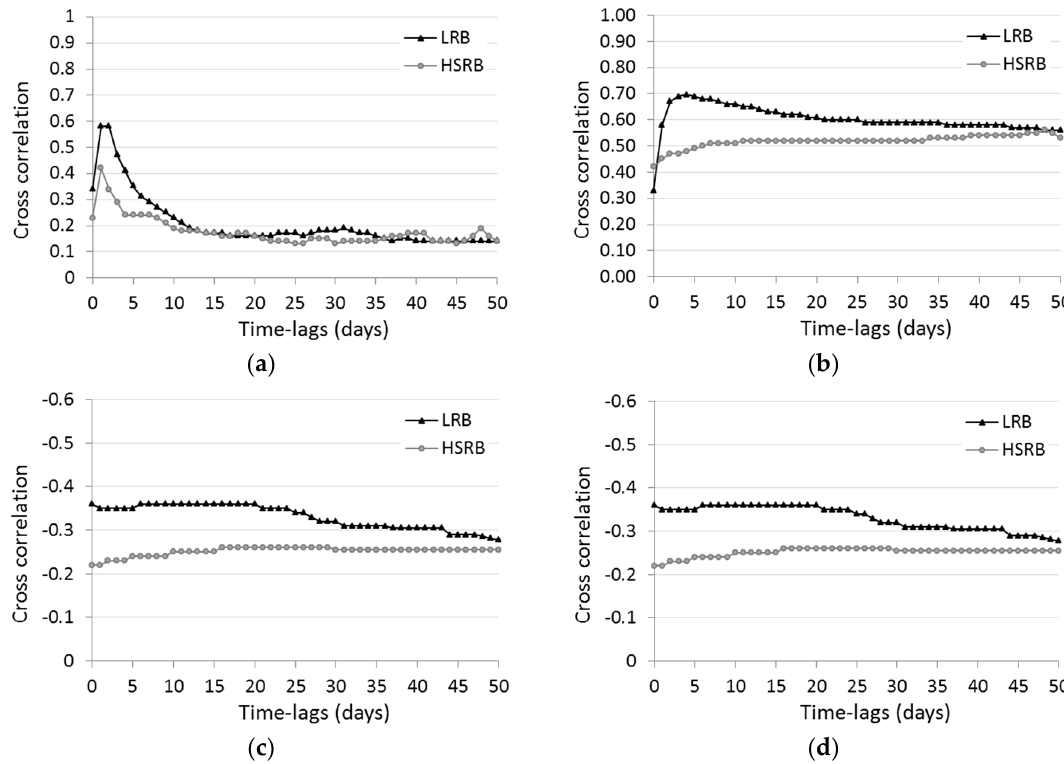
Figure 2. Cross-correlation analyses for LRB and HSRB between daily streamflow and ( a ) daily precipitation; ( b ) total rainfall of the preceding n days; ( c ) daily temperature; ( d ) mean temperature over the previous n days.